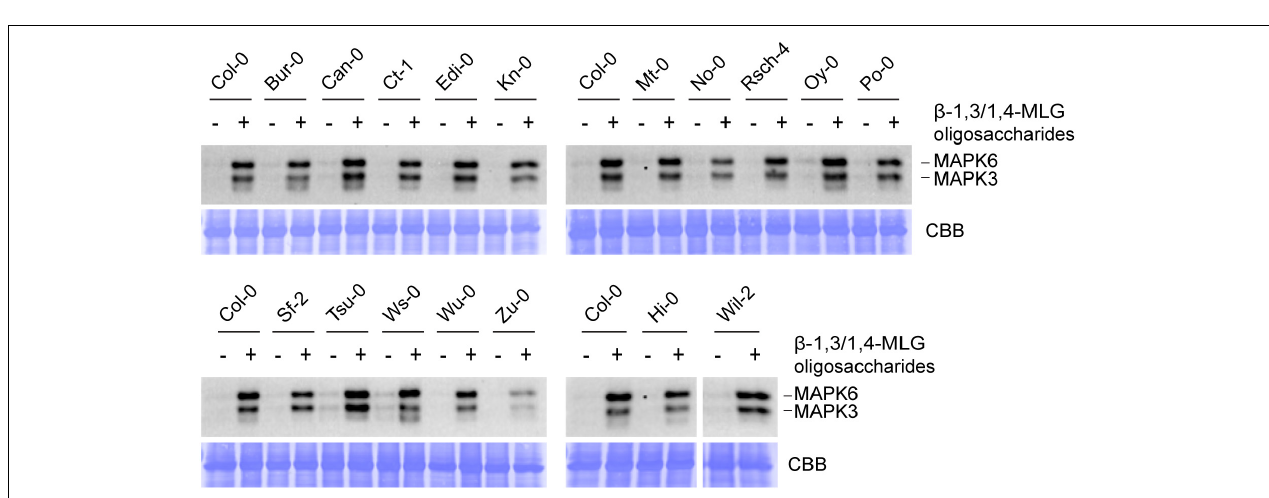
FIGURE 3 | β -1,3/1,4-MLG oligosaccharides induced activation of MAPK is independent of known PTI components. MAPK activation in 14-day old seedlings of (A) Col-0, cerk1 -2, lyk5 -2 lyk4 -2, lym2 -1, and lym2 -4, (B) Col-0, fls2c , efr -1, (C) Col-0, sobir1 -12, sobir1 -14 and (D) Col-0, bak1 -4 and bak1 -5 upon elicitation with enzymatically generated with β -1,3/1,4-MLG oligosaccharides. β -1,3/1,4-MLG oligosaccharides were generated upon incubation of the MLG polymer (10 mg ml − 1 ) with B. subtilis lichenase (1 U ml − 1 ) for 60 min ( Supplementary Figure 3 ). For seedling treatment, a 1:10 dilution of the hydrolysis products was used. Sodium phosphate buffer (1 mM) served as negative control. (A–C) Western Blot shows MAPK phosphorylation upon elicitation with the indicated elicitors for 12 min. (D) Western Blot shows phosphorylated MAPK at different time points (0, 5, and 15 min). As loading control, the PVDF membrane was stained with Coomassie Brilliant Blue (CBB). Data show the result from one biological replicate. The experiments were repeated twice with similar results.